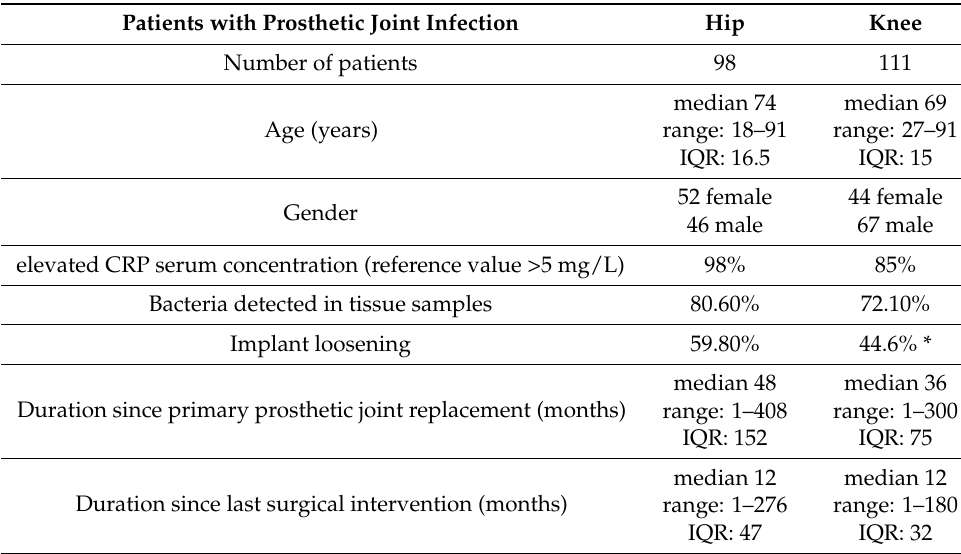
Table 1. Summary of patients ( n = 209) with prosthetic joint infection of the hip and knee included in the study; IQR (interquartile range).